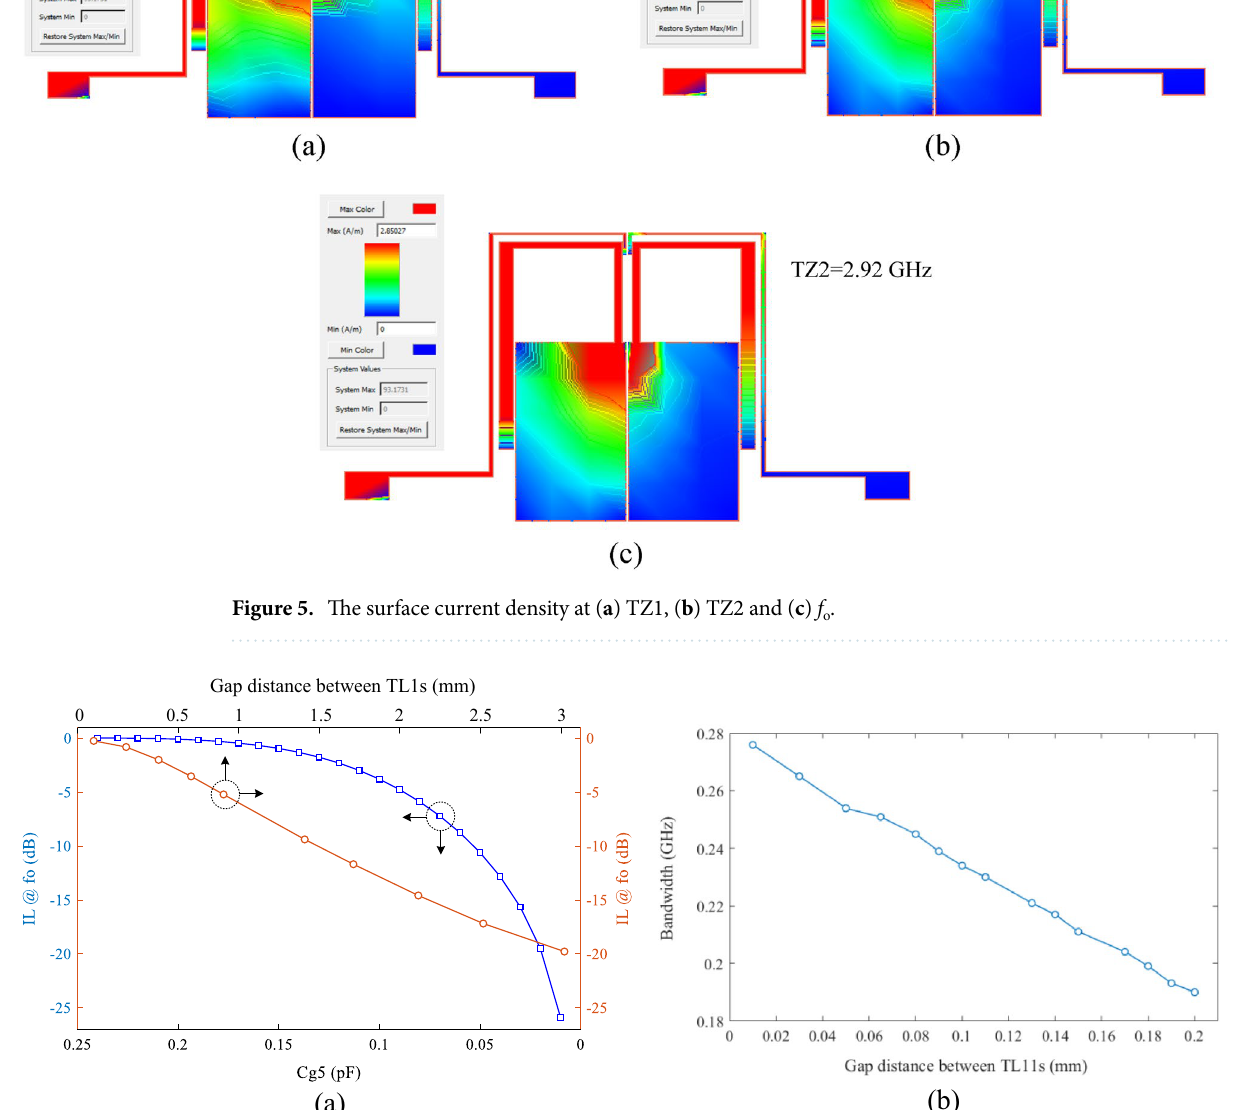
Figure 6. ( a ) The insertion loss value at f o versus variation of gap distance between TL1s and Cg5 value, ( b ) variation of bandwidth versus gap distance between